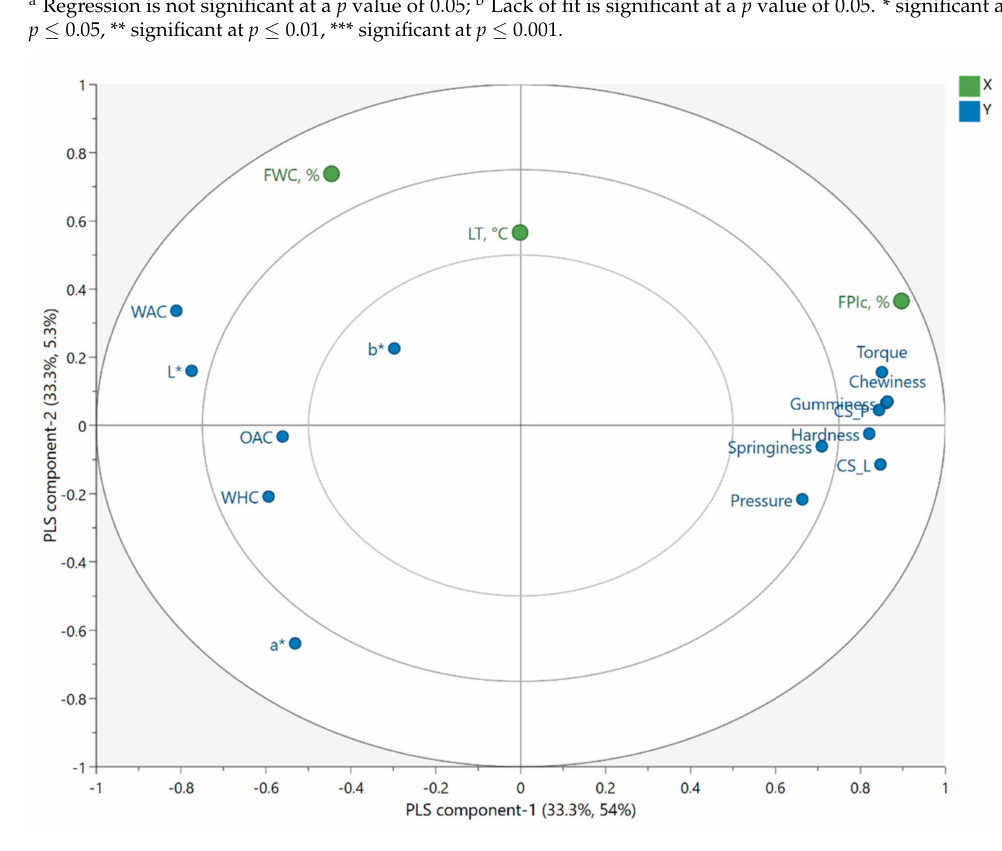
Table A2. Higher FPIc led to harder, gummier, and chewier meat analogues, as shown in the contour plots (Figure 2A–C, respectively). By contrast, a higher FWC led to softer and less gummy and less chewy meat analogues. The contour plots also show that when